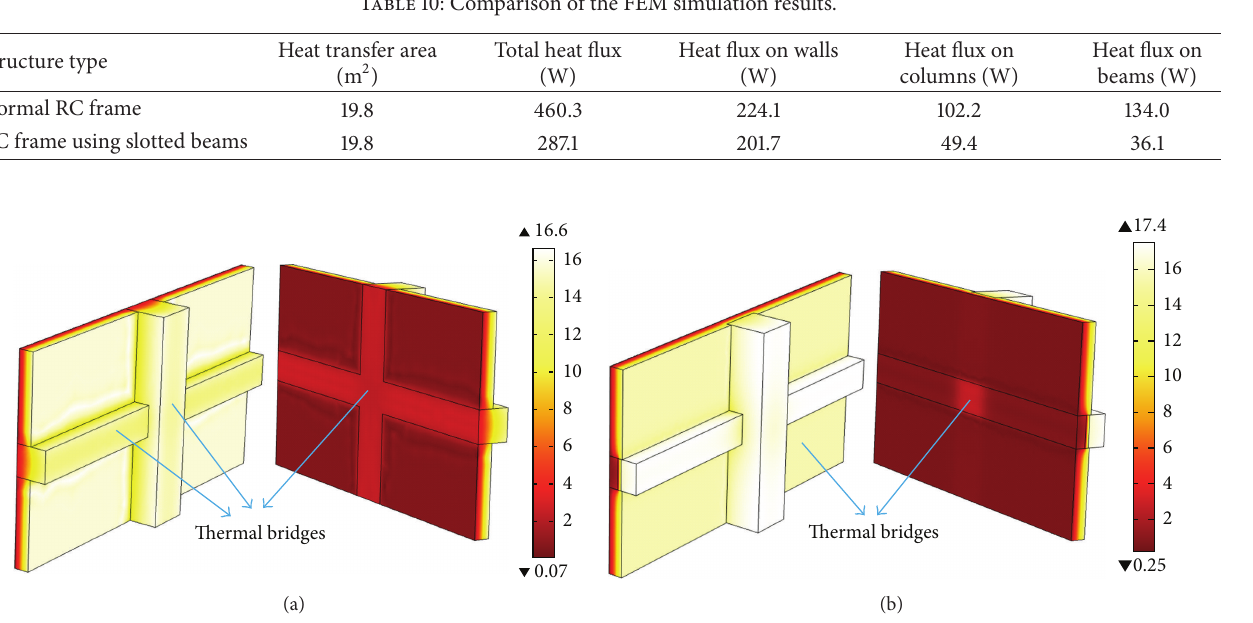
Figure 11: Surface temperature distribution of the FEM models (units: ∘ C): (a) normal frame and (b) frame using the slotted beam-wall